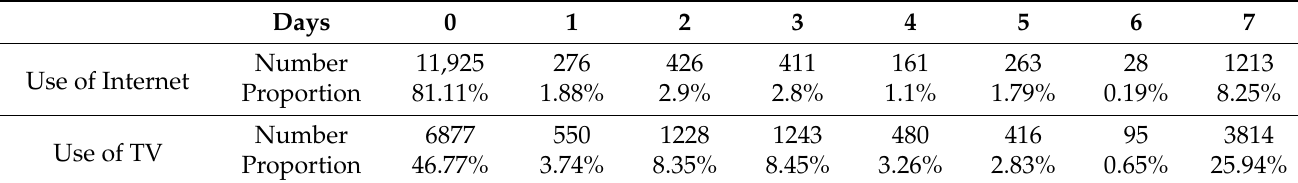
Table 2. Statistical analysis of rural residents obtaining news through the Internet and TV.